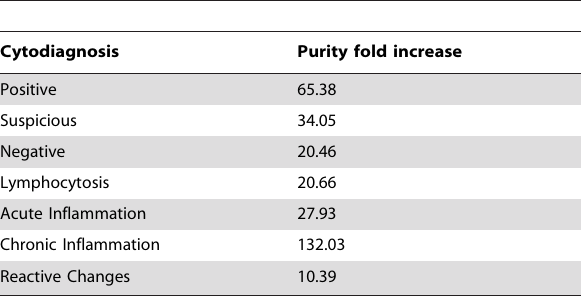
Table 2. Purity Increases Following Processing with the Centrifuge